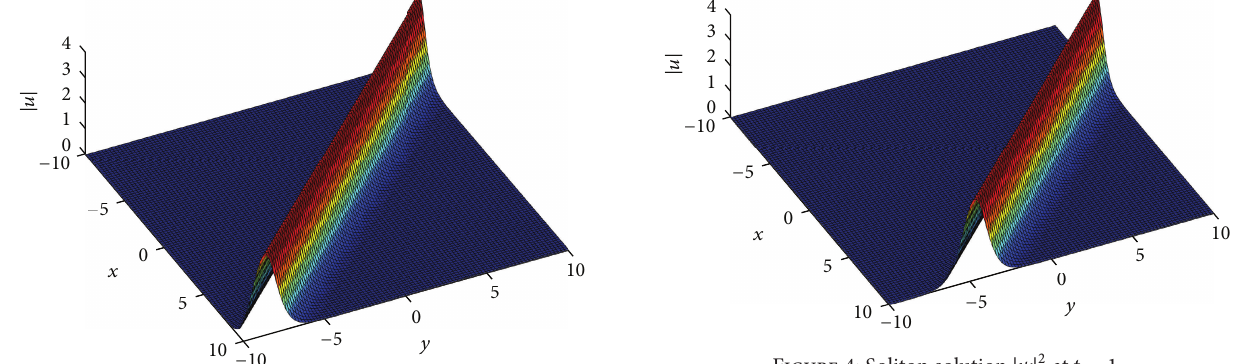
Figure 4: Soliton solution |𝜓| 2 at 𝑡 = 1